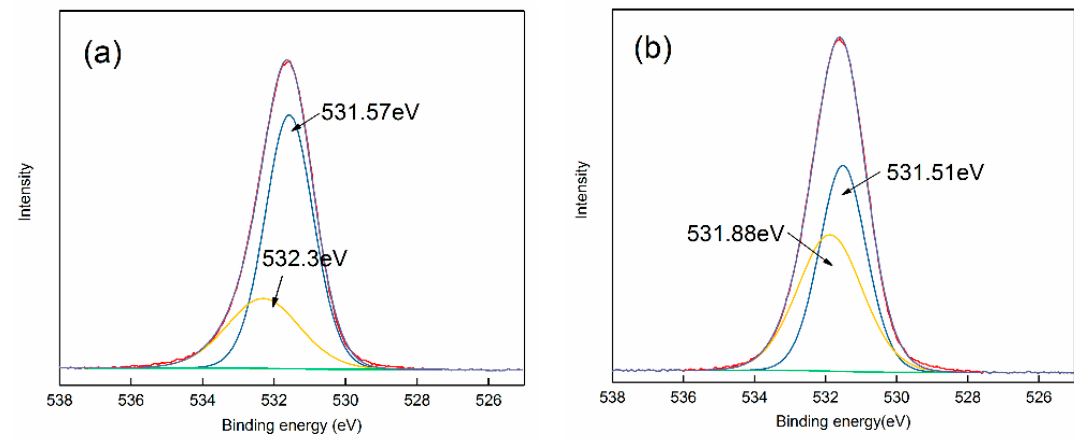
Figure 9. O 1s spectra of ( a ) untreated bastnaesite; ( b ) bastnaesite treated with strontium ions.